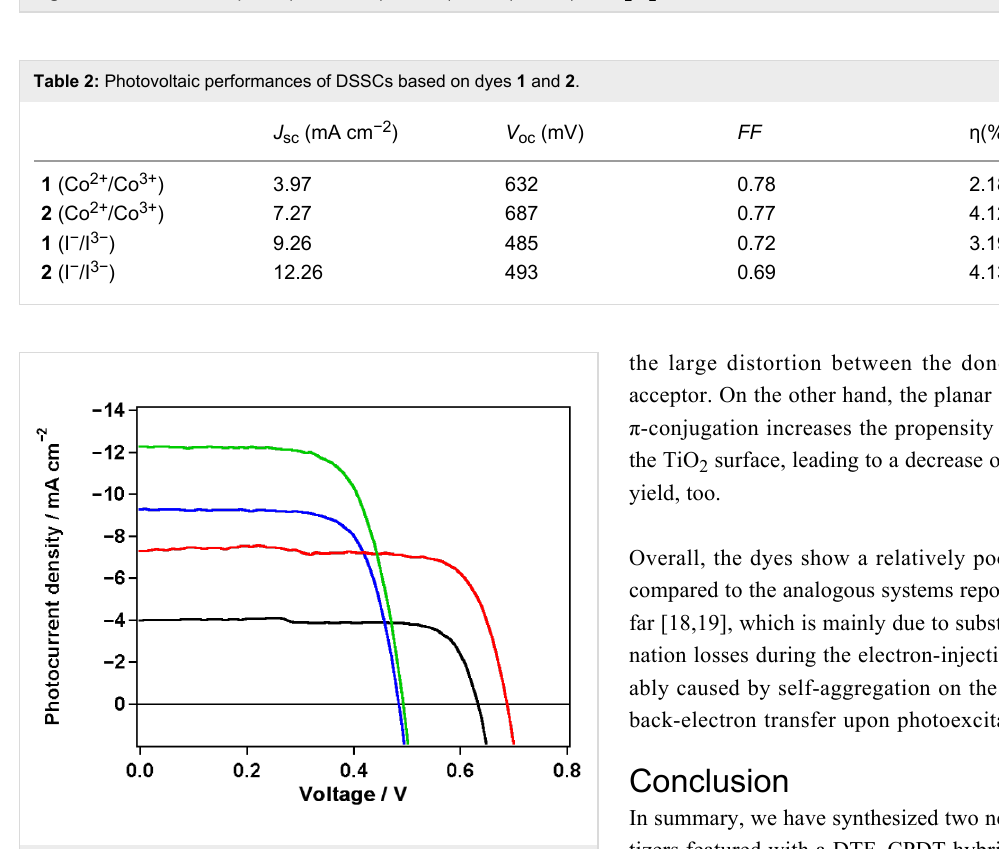
Figure 3: Electronic absorption spectra of 1 (blue line) and 2 (red line) in CH 2 Cl 2 solutions.